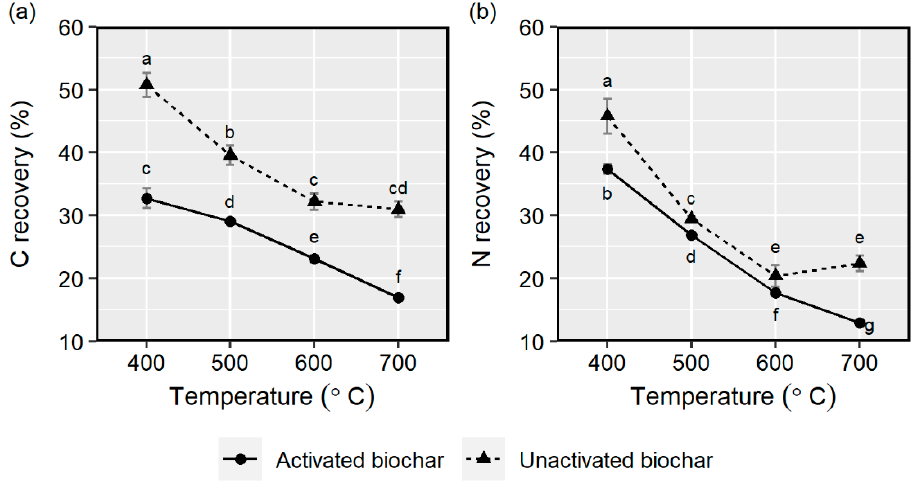
Figure 2. Recovery of ( a ) carbon (C) and ( b ) nitrogen (N) in activated biochar and unactivated biochar produced from poultry litter at pyrolysis temperatures between 400 and 700 °C. Error bars represent one standard deviation (n = 3). Different letters above/below error bars represent significant differences at p ≤ 0.05.